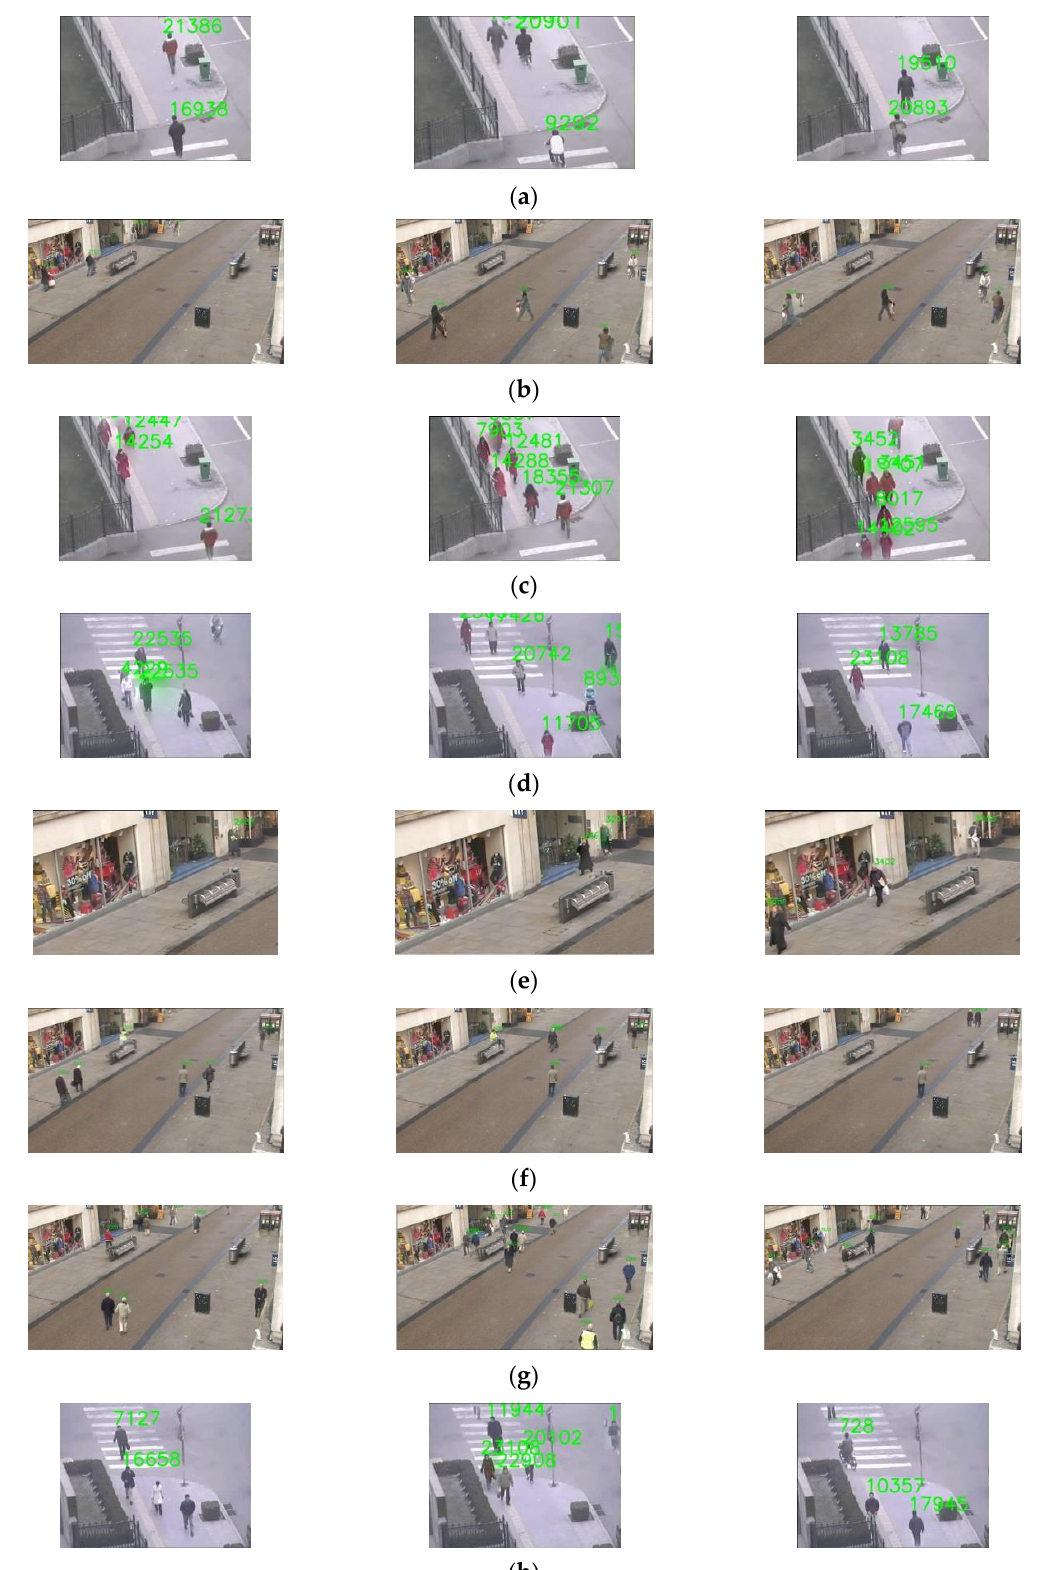
Figure 6. Sample frames of the generated synopsis video from each query: ( a ) Query1, ( b ) Query2, ( c ) Query3, ( d ) Query4, ( e ) Query5, ( f ) Query6, ( g ) Query7, ( h ) Query8.